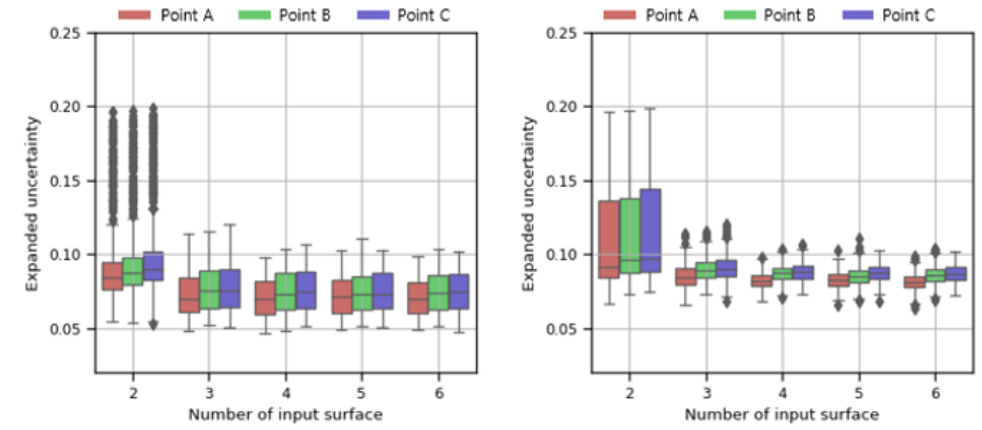
Figure 14. Expanded uncertainty of PMV: winter ( left ), summer ( right